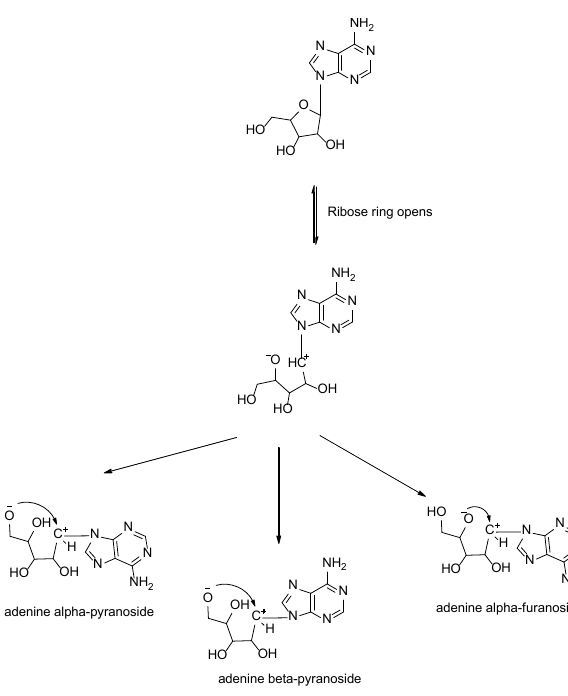
Scheme 4: The possible mechanism of anomerization of adenosine at pH